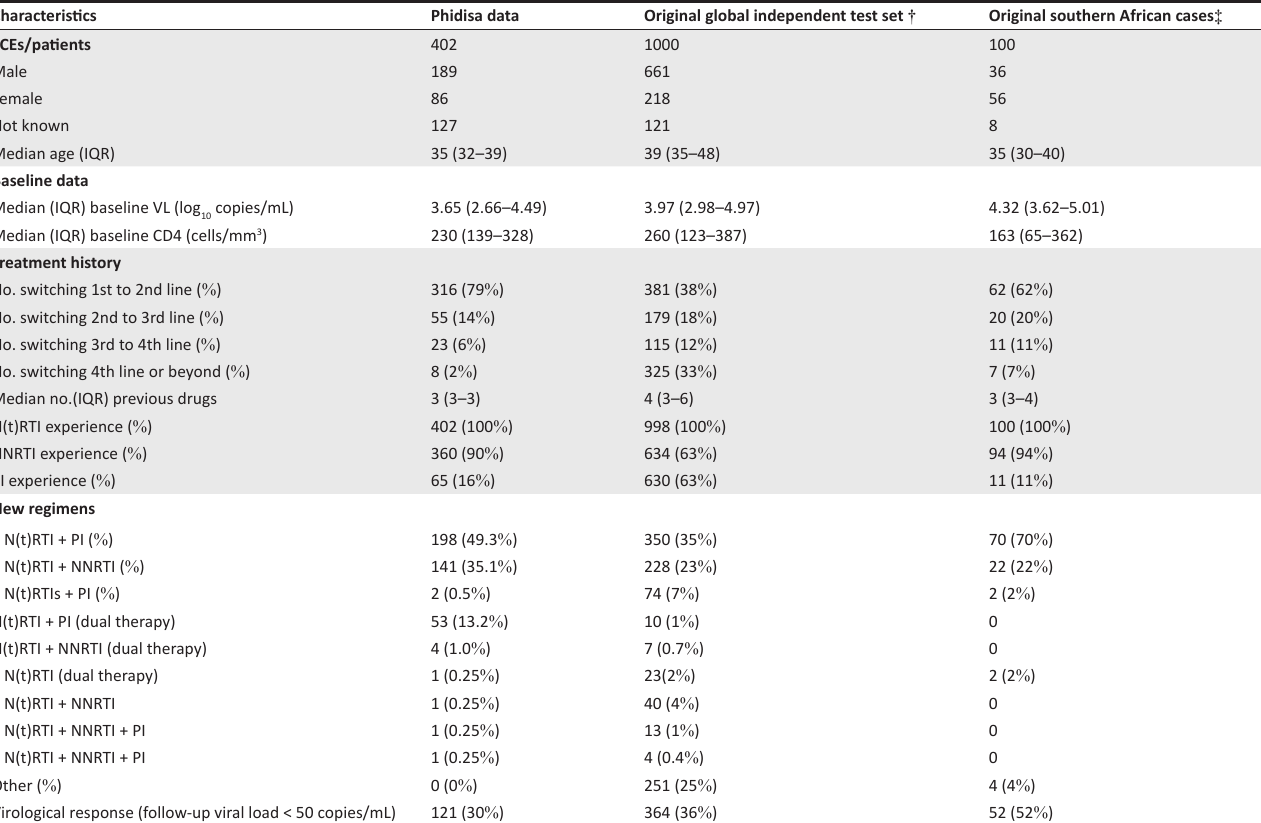
TABLE 1: Characteristics of the TCEs in the Phidisa and original test data sets .